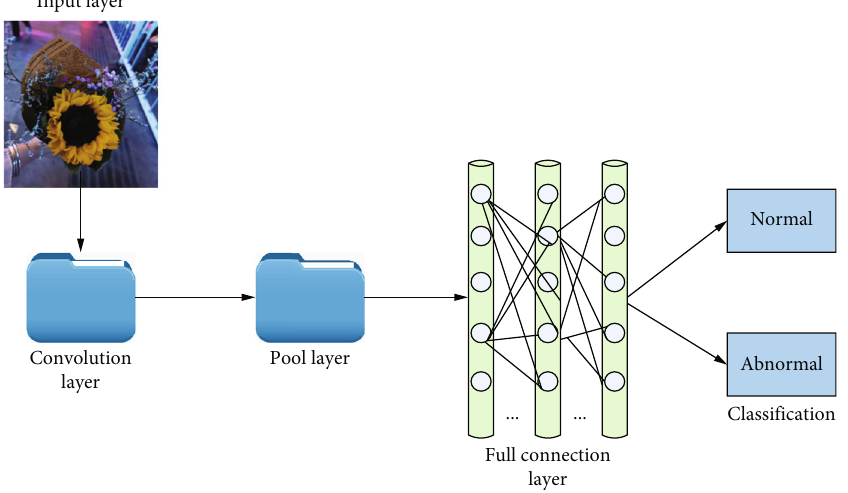
Figure 1: Schematic diagram of convolutional neural network